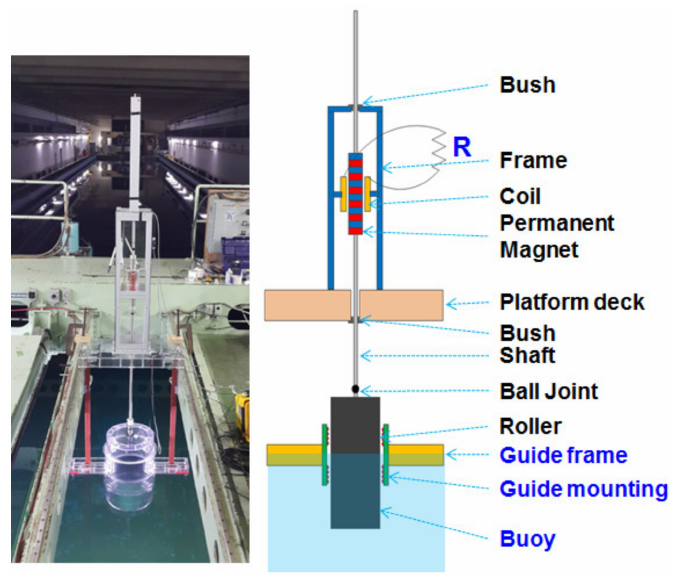
Figure 6. Photograph of a 1/10 scale model and experimental